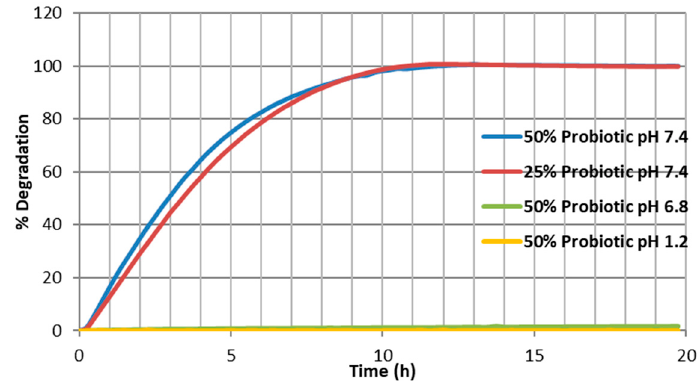
Figure 7. Average degradation profiles ( n = 3) for Biocare ® Bifidobacterium Probiotic/shellac matrix across 3 pH ranges.